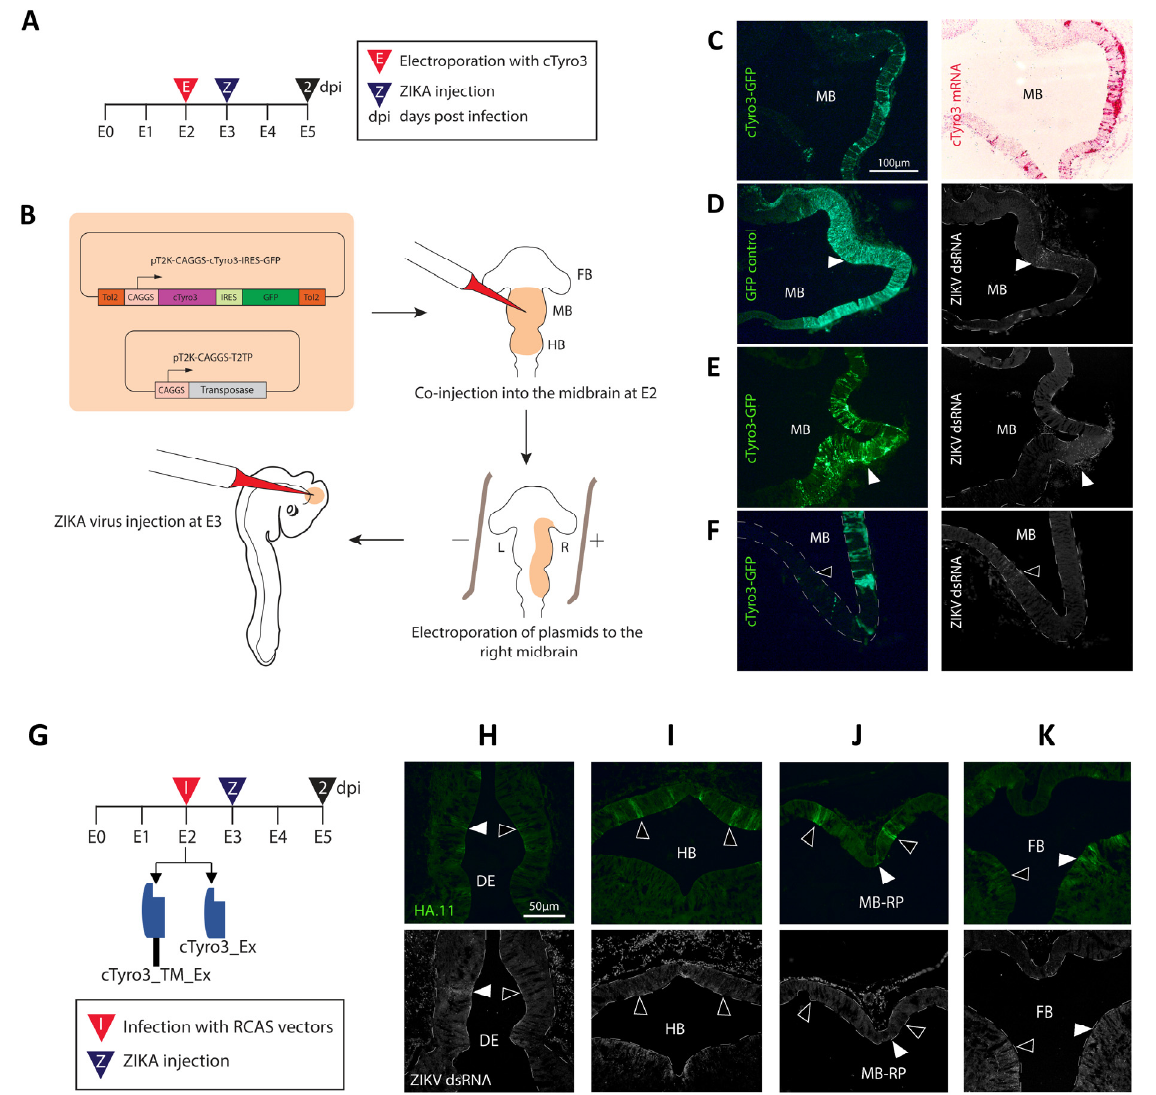
Figure 4. Ectopic cTyro3 overexpression or truncation does not correlate with the locations of ZIKV infection. ( A ) Timeline of the experiment to test the effect of cTyro3 overexpression on ZIKV infection in the embryonic brain. ( B ) Experimental methodology for expressing plasmids encoding bicistronic mRNA to encode full-length cTyro3 and GFP proteins, and designed for stable integration and expression in chick embryos using a transposase expression plasmid. Both plasmids are electroporated to the right side of the neural tube at E2 (black triangle, 2 dpi) followed by ZIKV injection into the midbrain ventricle 24 h later (blue triangle, Z). ( C – F ) Analysis of ZIKV infection in the presence of ectopic cTyro3 from 18 embryos. ( C ) Co-localization of GFP protein and cTyro3 mRNA after electroporation was confirmed using immunohistochemistry and RNAscope in situ hybridization, respectively, on alternate sections at E5. Note how high cTyro3 over-expression appears in the dorsal midbrain in comparison to endogenous expression levels. ( D – F ) A dsRNA antibody was used to localize ZIKV infection in the red channel (shown in grey scale). ZIKV infection did not consistently overlap with ectopic cTyro3 transfection (visualized by GFP in the green channel) as overlap could be seen for both ( D ) the control (n = 1/5 embryos) as well as ( E ) the experimental samples (n = 3 embryos). ( F ) Regions of the midbrain that did not have any ectopic cTyro3 also showed ZIKV infection (open arrowheads) while cTyro3-transfected cells (green) nearby had no infection (n = 12 embryos). Scale bar = 100 µm. ( G ) Timeline of experiment to test the effect of cTyro3 dominant-negative mutants on ZIKV infection. RCAS viral vectors encoding the truncated cTyro3 mutants were injected into the E2 neural tube (black triangle, 2 dpi), followed by ZIKV injection one day later (blue triangle, Z). ( H – K ) Known hotspots of ZIKV infection were